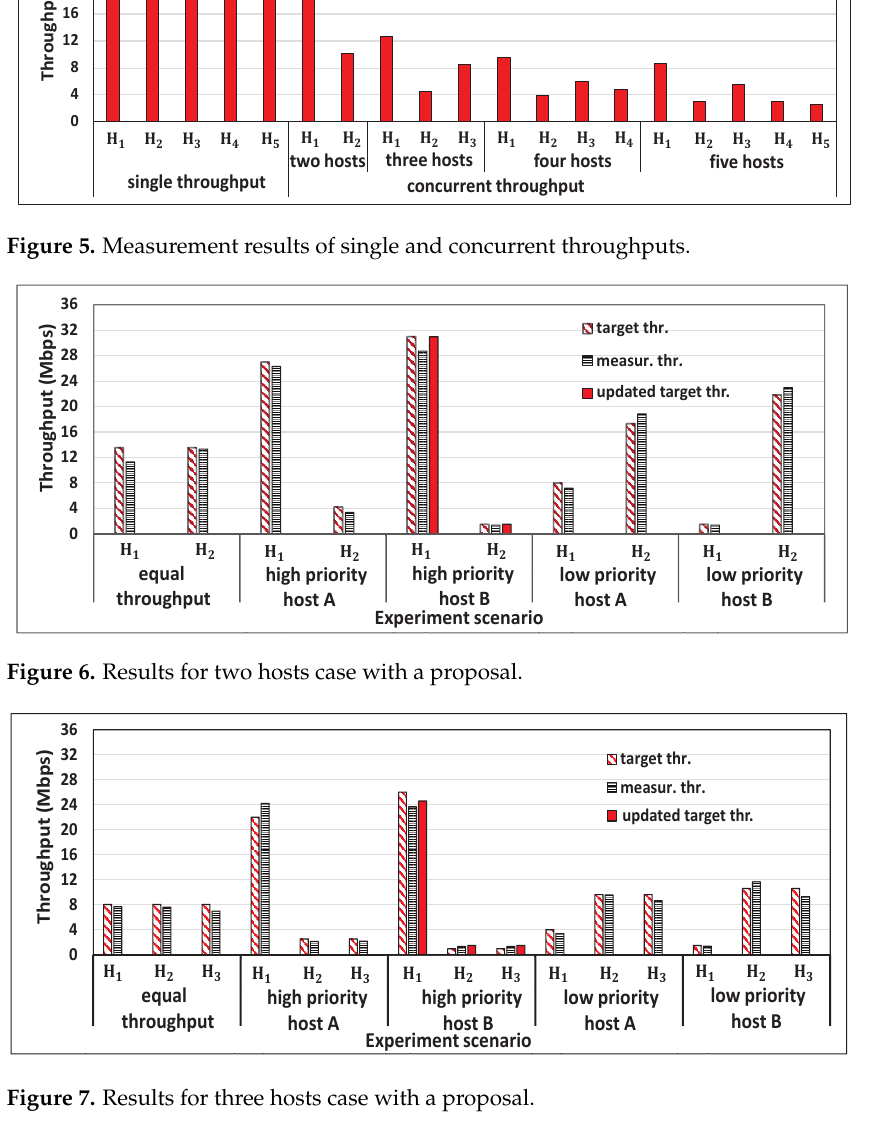
Figure 7. Results for three hosts case with a